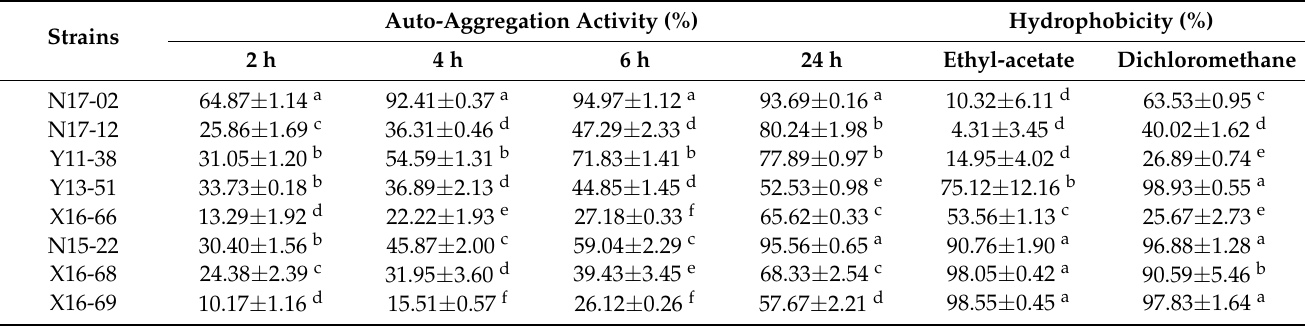
Table 4. Auto-aggregation ability and hydrophobicity to ethyl-acetate and dichloromethane. Auto-Aggregation Activity Strains